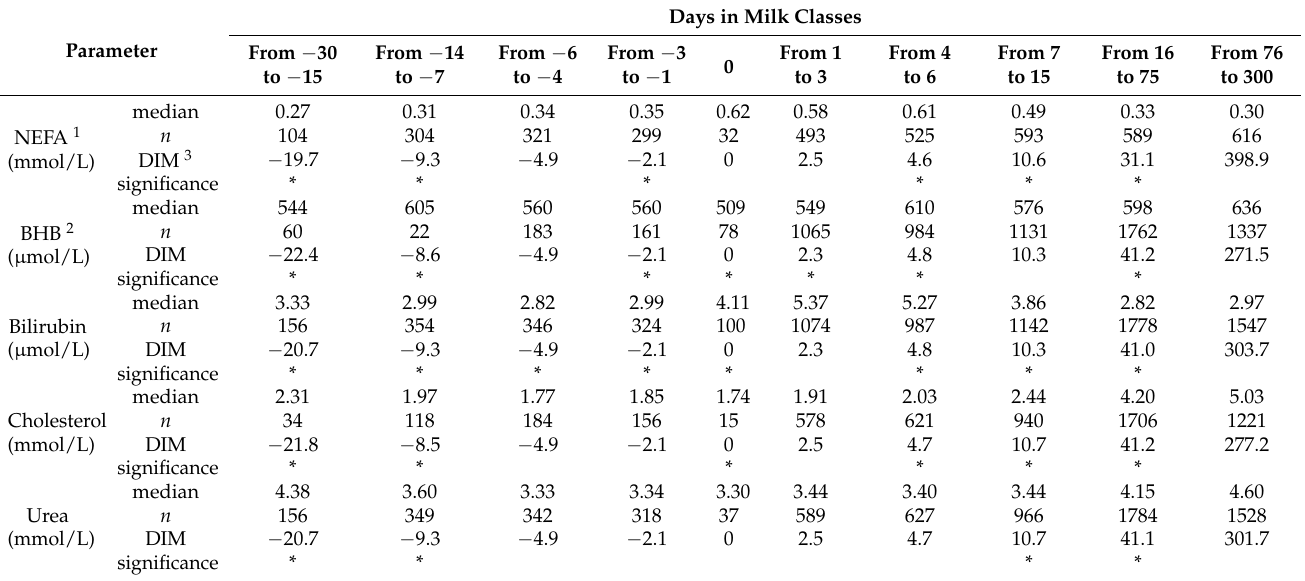
Table A1. Serum parameters of energy and protein metabolism in ten DIM classes in primi- parous cows.